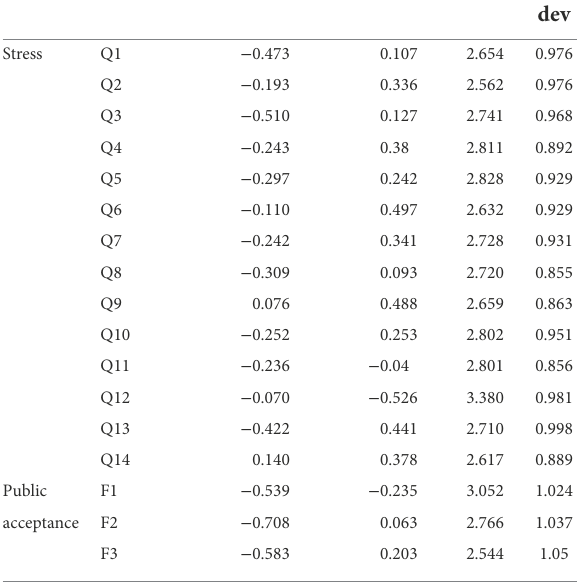
TABLE 3 Test results of the difference of demographic characteristics on public acceptance (overall